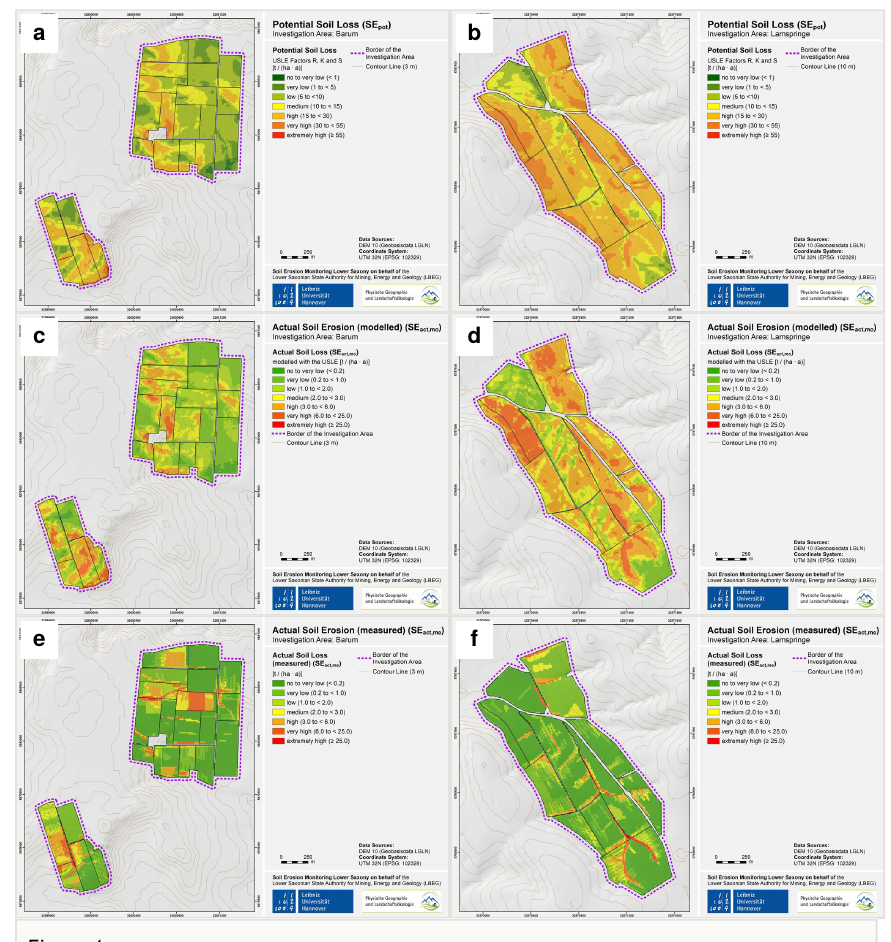
Figure 4. Maps of potential soil erosion (SE ), actual soil erosion (modelled) (SE ) and actual soil erosion (measured) (SE ) for two exemplary investigation